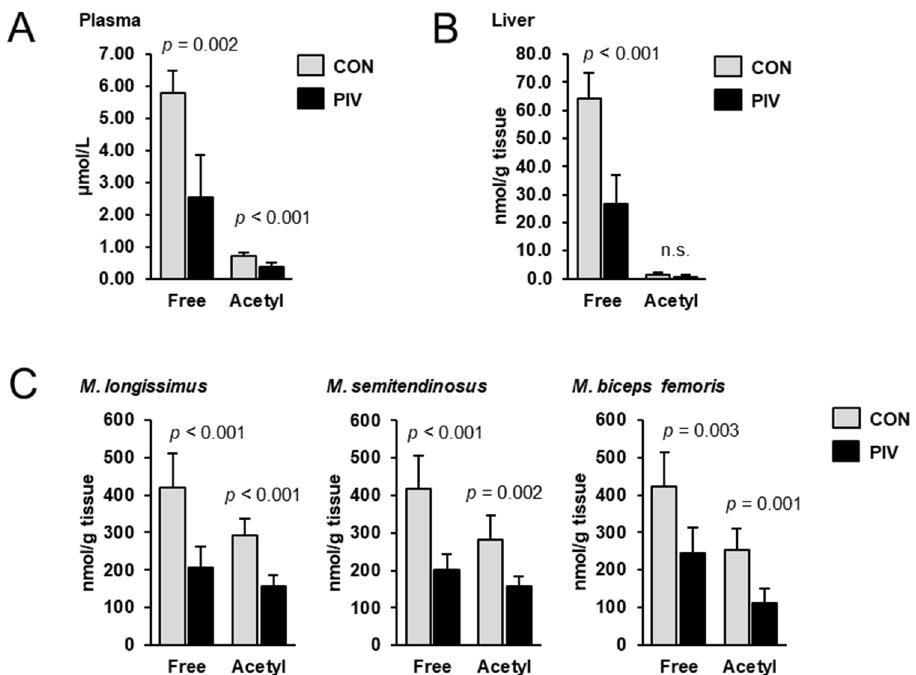
Figure 1. Concentrations of free carnitine and acetylcarnitine in plasma ( A ), liver ( B ) and different skeletal muscles ( C ) of 5-week-old pigs orally administered either vehicle (group CON) or pivalate (group PIV) for 28 days as determined by LC-MS/MS. Bars are means ± SD for n = 6 pigs/group.